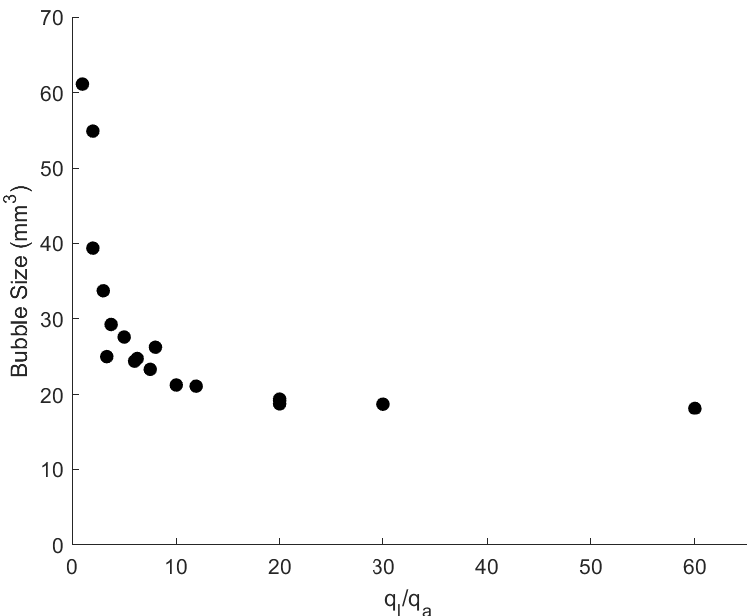
Figure 3. The relationship between bubble size and liquid/air flow rate